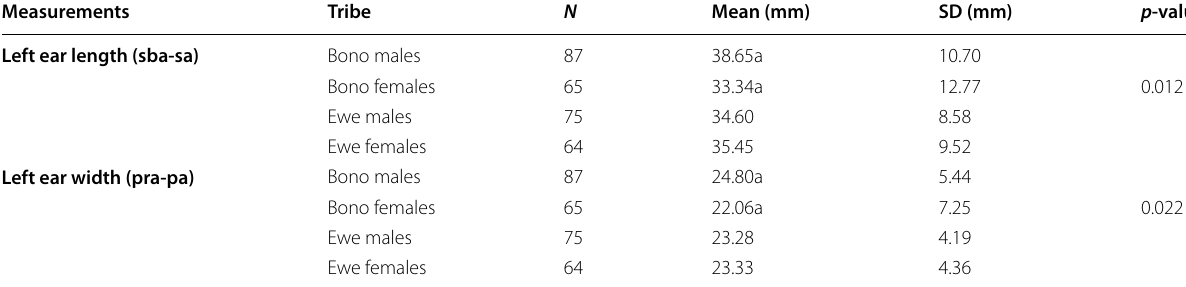
N number of participants, SD standard deviation, mm millimetre, pra-pa preaurale to postaurale, sba-sa subaurale to superaurale. a differences existing between the mean values of two tribes by means of a post hoc test (the p values are only the result of the ANOVA and not the post hoc test). Statistical significance at p <